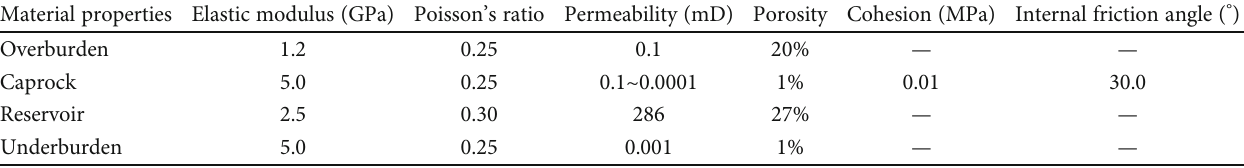
Table 1: Material parameters of S gas storage.